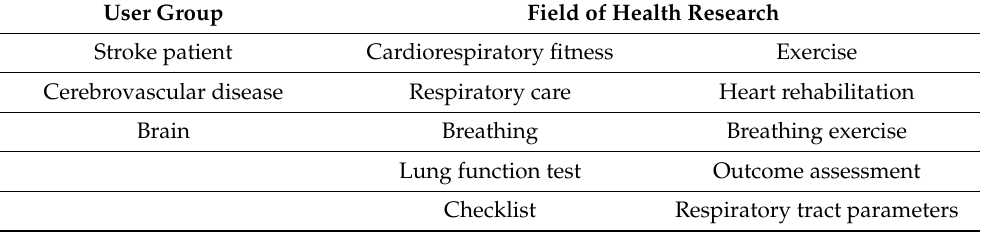
Table 2. Emtree search terms.